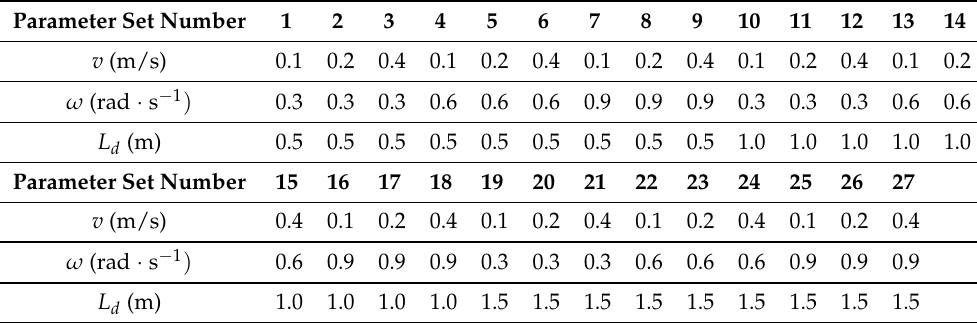
Table 1. The variants of the parameters sets: linear velocity, angular rate and look ahead distance. Parameter Set